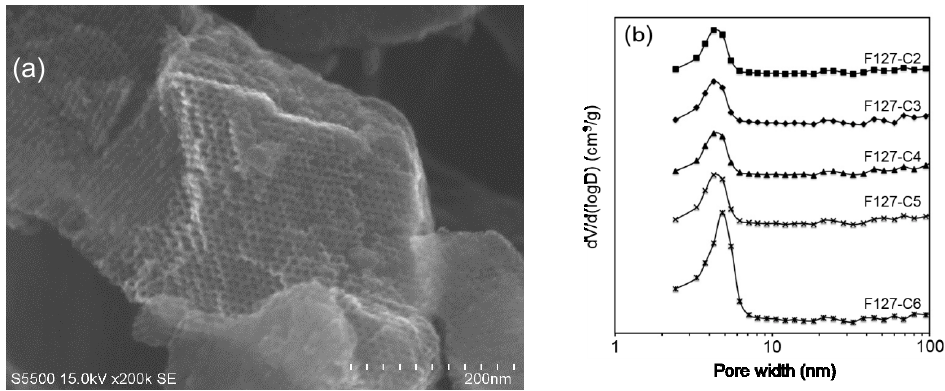
Figure 12. Schematic of the preparation of mesoporous Fe/N/C catalysts [56].